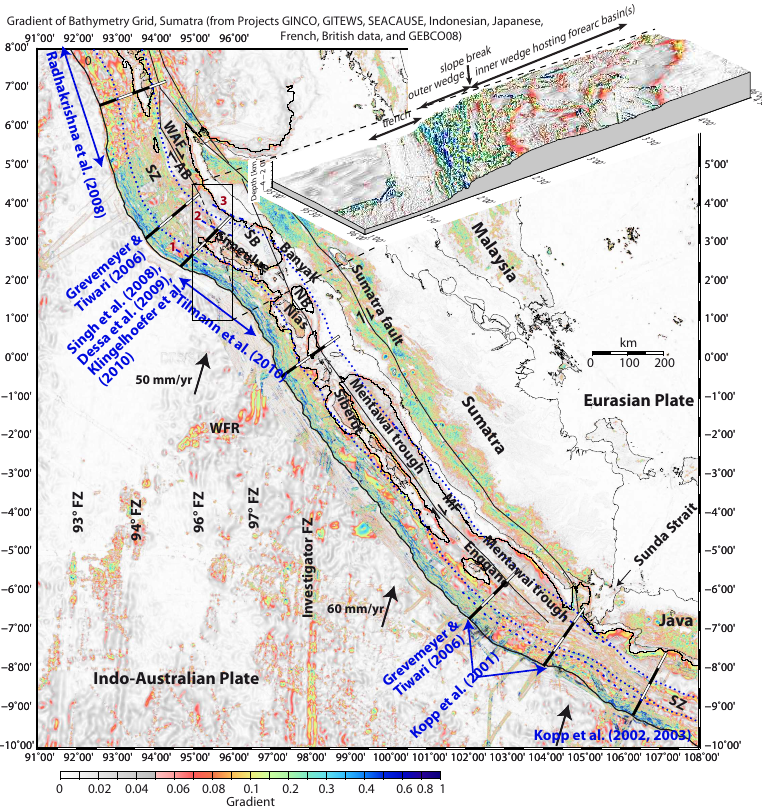
Fig. 4. Gradients of bathymetric data off Sumatra. Annotations and details as described in Fig. 2. Blue dashed lines mark the updip and downdip limits of the SZ, here. Inset shows close-up of representative area off Sumatra (same region as shown in Fig. 6). Gradients are draped on perspective view of bathymetry relief. Trench, outer wedge, slope break and inner wedge are indicated.